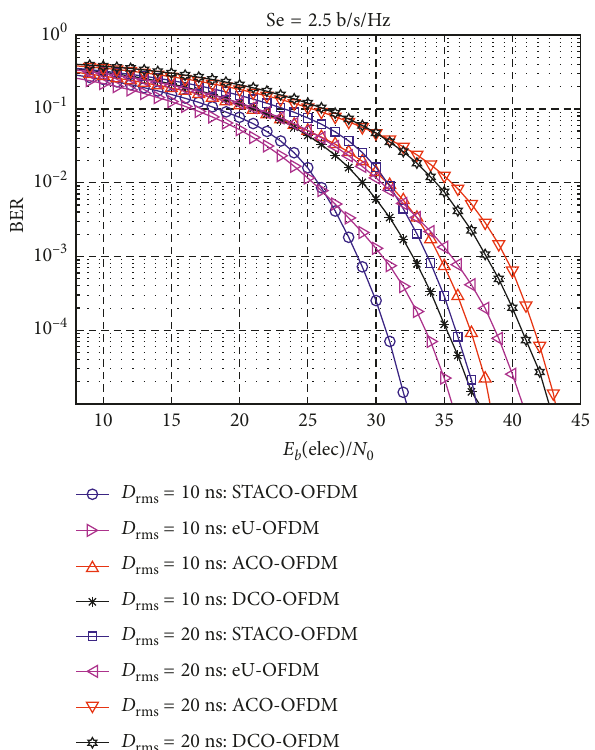
Figure 10: BER versus electrical SNR performance of STACO- OFDM, ACO-OFDM, and DCO-OFDM with spectral efficiency of 2.5bits/s/Hz over multipath channel with D rms Table 2: Simulation parameters for BER versus optical power. Simulation parameters